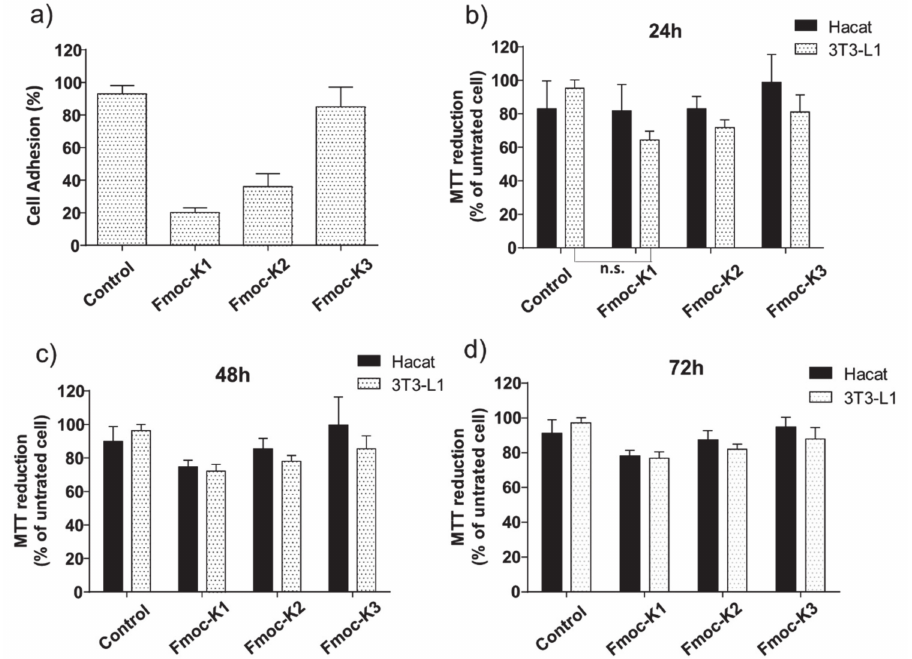
Figure 6. In vitro biological assays. ( a ) Cell adhesion on pre-casted hydrogels. ( b – d ) Compatibility of hydrogels with eukaryotic cell culture. The 3T3-L1 cells were seeded on the indicated hydrogel pre-casted in 96-well plates. Cell adhesion (% of adherent viable cell), viability upon adhesion (% viable cells upon plating), duplication rate for the indicated hydrogels are reported as mean ± SD of at least three replicates. MTT assay conducted on haCat (black bars) and 3T3-L1 (dotted white bars) cell lines treated for 24 h ( b ), 48 h ( c ), and 72 h ( d ) with Fmoc-K1, Fmoc-K2, and Fmoc-K3 hydrogels conditioned media. Cell survival was expressed as percentage of viable cells in the presence of conditioned media, compared to control cells grown in their absence. Error represent SD of three independent experiments. n.s. = not significant, Mann–Whitney t